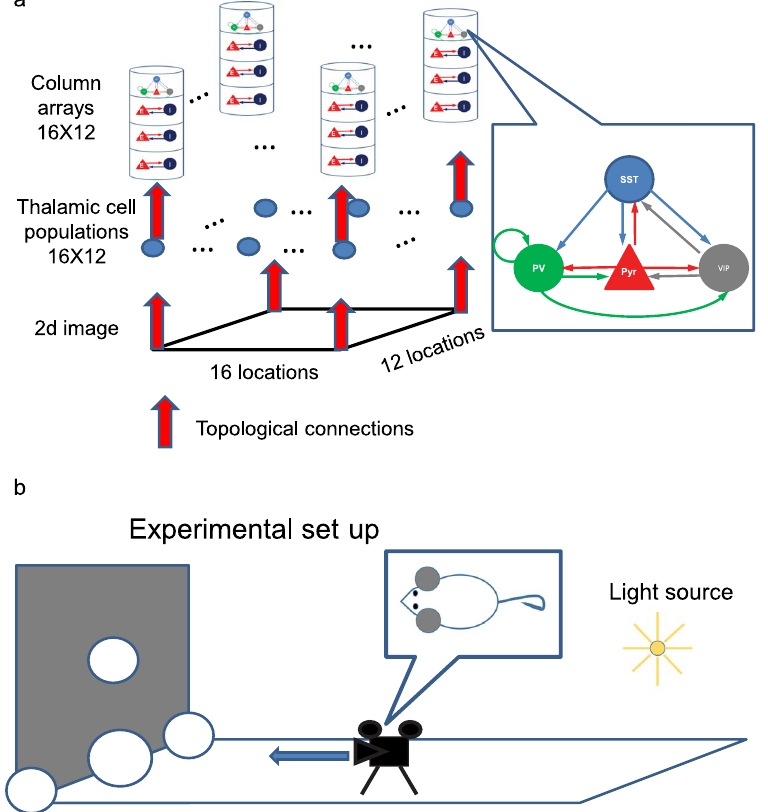
Figure 6. The model structure of computational model of V1. ( a ) Structure of the computational model. In the computational model, we consider more connections among the four cell types 13 than those used in the firing rate model. The model consists of 192 columns distributed over a 16-by-12 grid. The receptive field of each column covers non-overlapping image patches consisting of 40-by-40 pixels; the rendered images consist of 640-by-480 pixels. All inter-columnar connections are established using a periodic boundary condition; see Supplementary Table 3. ( b ) Virtual